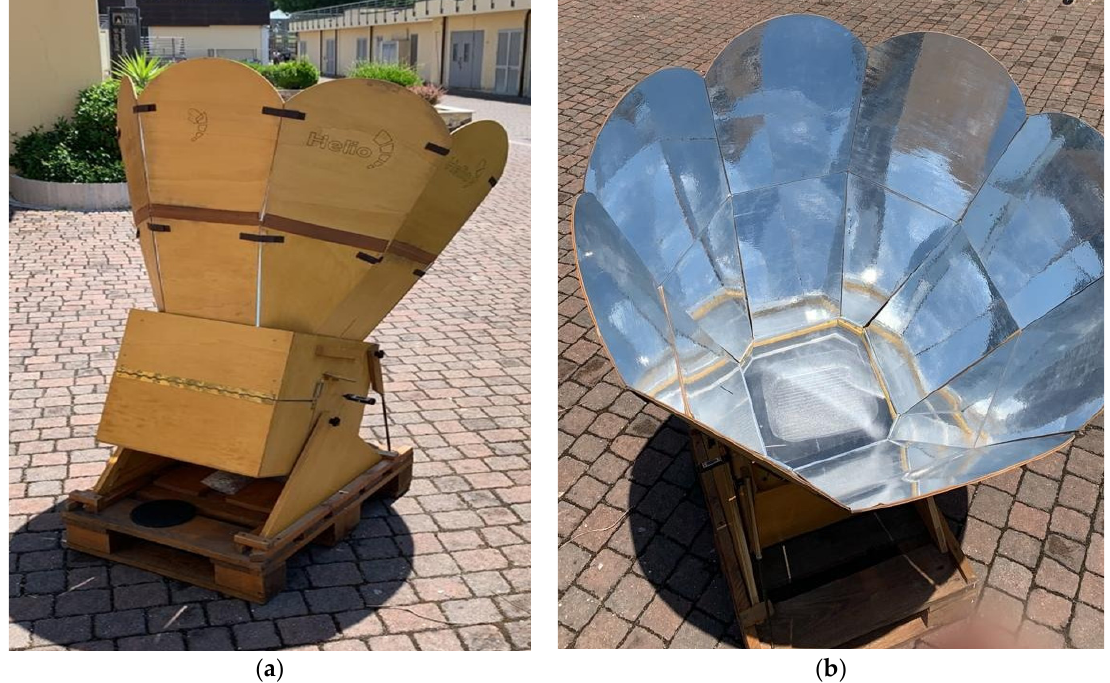
Figure 1. Helio© solar cooker, kindly provided by Eng. Alessandro Varesano. ( a ) Structure of the re fl ection panels and cooking chamber; ( b ) Vision of the cooking chamber from the glass panel. The grilling pan is visible